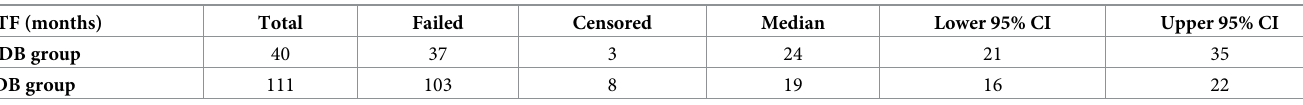
Table 3. Time to treatment failure in the double-dose and standard-dose bevacizumab groups. TTF